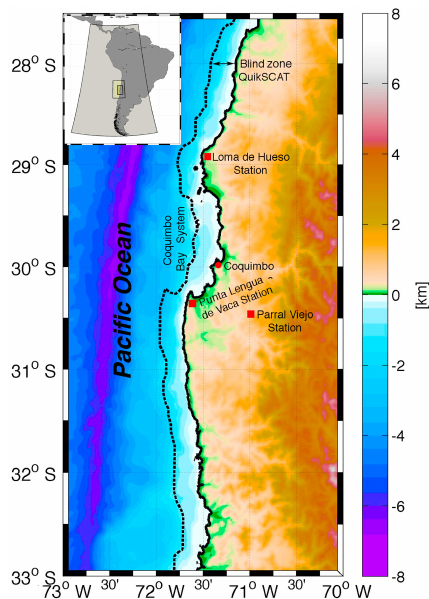
Figure 1. Study area showing bathymetry and topography of the coastal terrain. The dotted thick line indicates the western boundary of the coastal band where satellite information ( ∼ 25km offshore) is absent. Red squares indicate the location of the three weather stations at Loma de Hueso, Punta Lengua de Vaca and Parral Viejo. The inset plot shows the three model domains used in the WRF simulations (36, 12 and